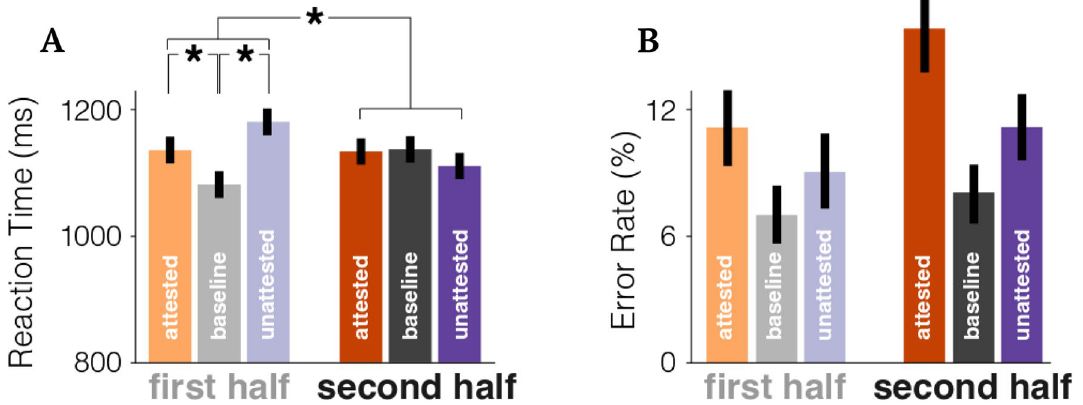
Figure 2. Behavioral responses to the word-picture matching task. ( A ) Behavioral reaction times showing that people are slower identifying pictures at the beginning of the experiment when the word was pronounced non-canonically, but adjust to it as the experiment goes on. The results show a main effect of condition, and an interaction such that attested and unattested conditions are responded to significantly faster as a function of exposure. ( B ) Error rates showing that participants made numerically more mistakes for non-canonical speech, though this difference is not significant—regardless of exposure. Note that the statistical analysis was based on a continuous measure of exposure, but trials are grouped here for illustrative